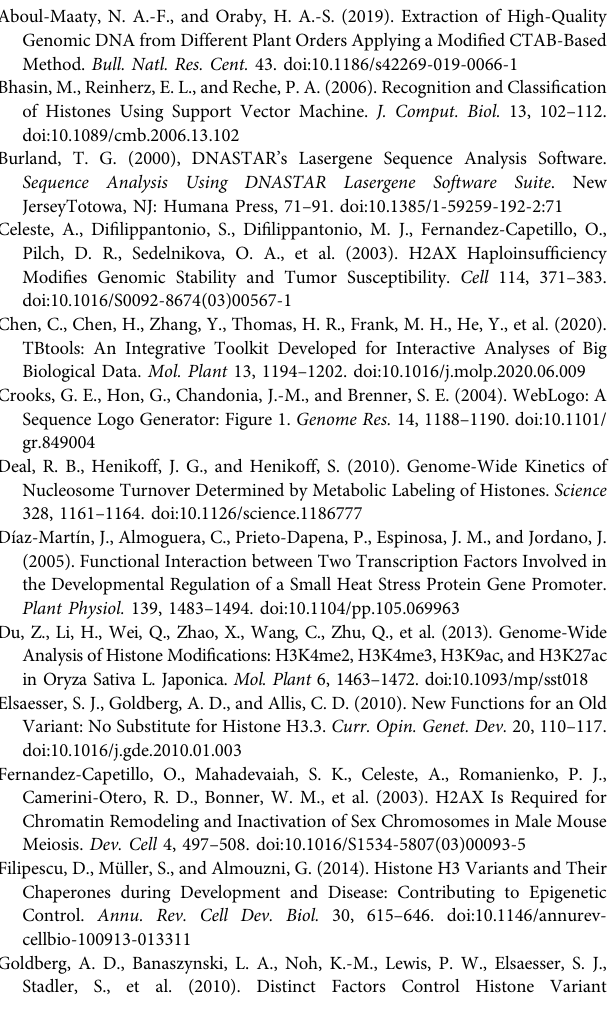
Supplementary Table 1 | SNP information and KASP marker detail. Supplementary Table 2 | Recipe of GmHH3-3 KASP assay for 1x sample. Supplementary Table 3 | HH3 gene IDs of 12 species. Supplementary Table 4 | Biophysical properties of GmHH3 genes.